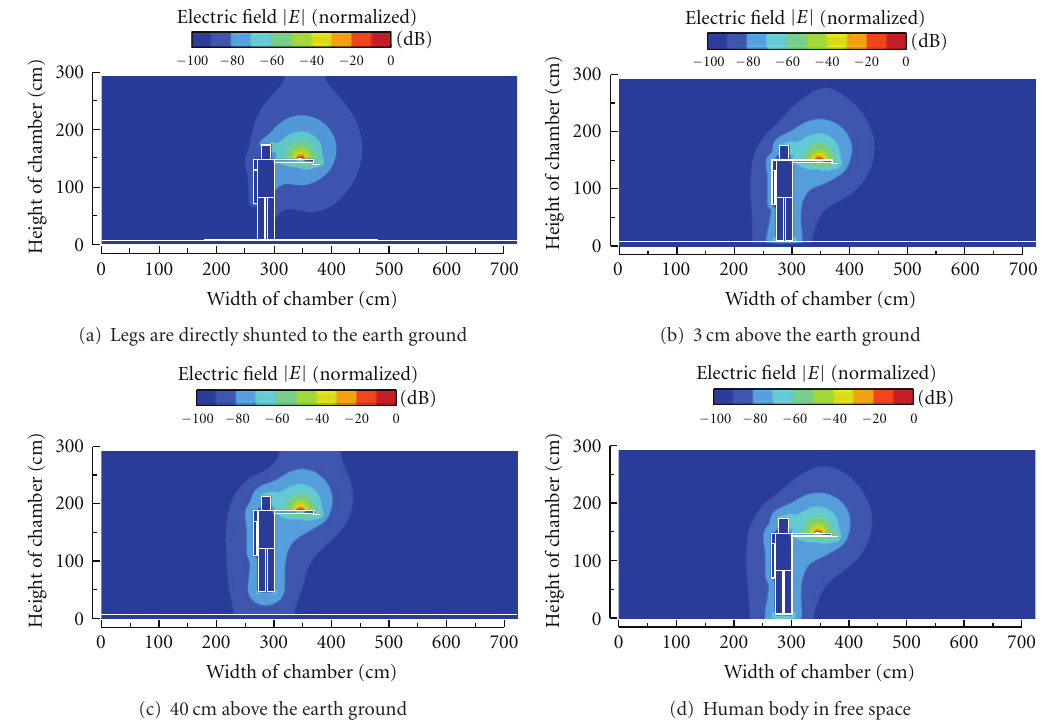
(d) Human body in free space